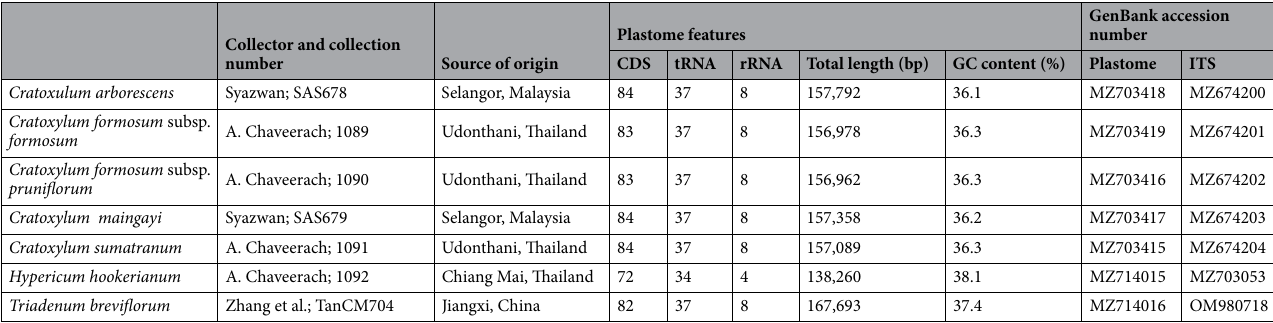
Table 1. General characteristics of complete plastid genomes of the seven taxa of Hypericaceae obtained in this study.